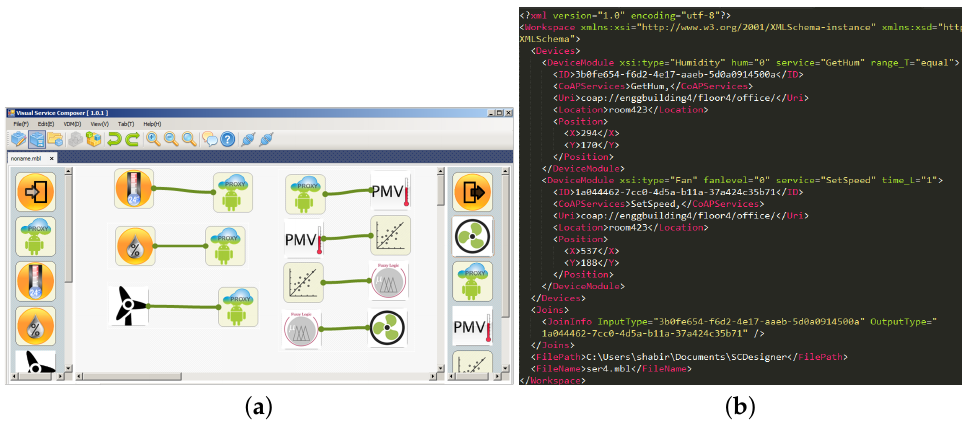
Figure 8. DIY toolbox service composition. ( a ) Virtual device; ( b ) XML representation.